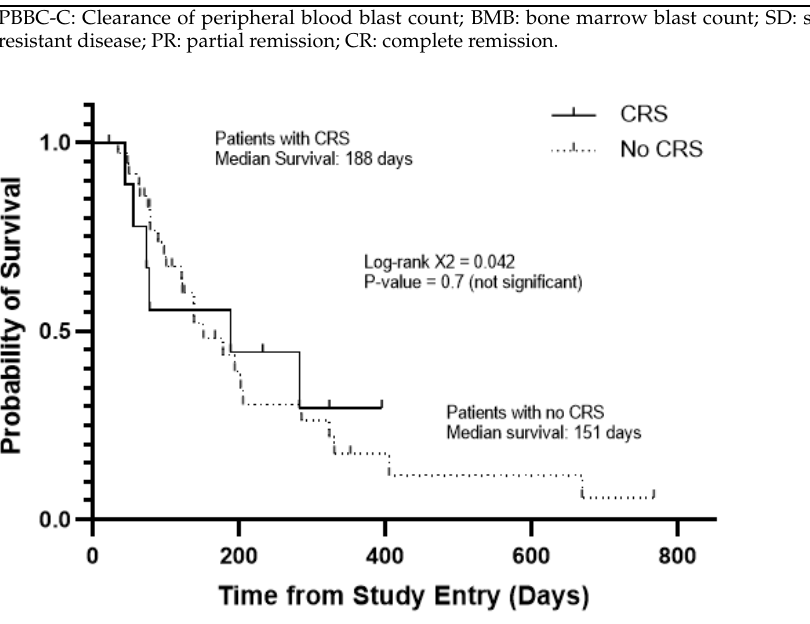
Figure 2. Survival outcome of AML/MDS patients according to development of CRS in the course of their APVO436 therapy. Depicted are the overall survival curves of the 10 patients who developed CRS and 36 patients who did not. See also Table 2. Table 3. CRS history of APVO436-treated R/R AML patients with favorable responses.